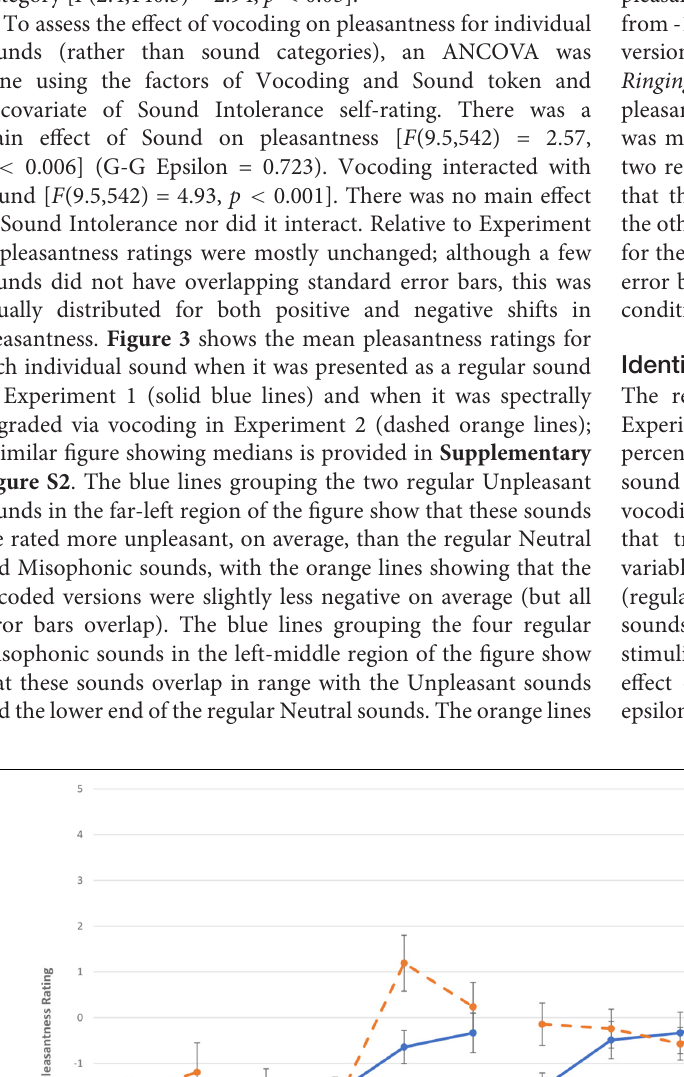
Frontiers in Psychology |